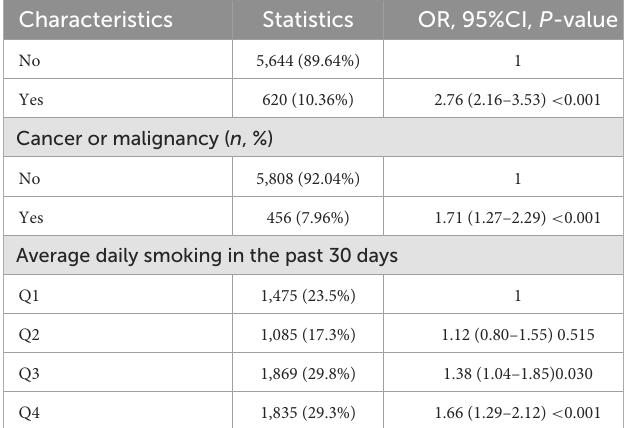
TABLE 5 Univariate analysis of depressive symptoms in the study population based on average daily smoking in the past 30